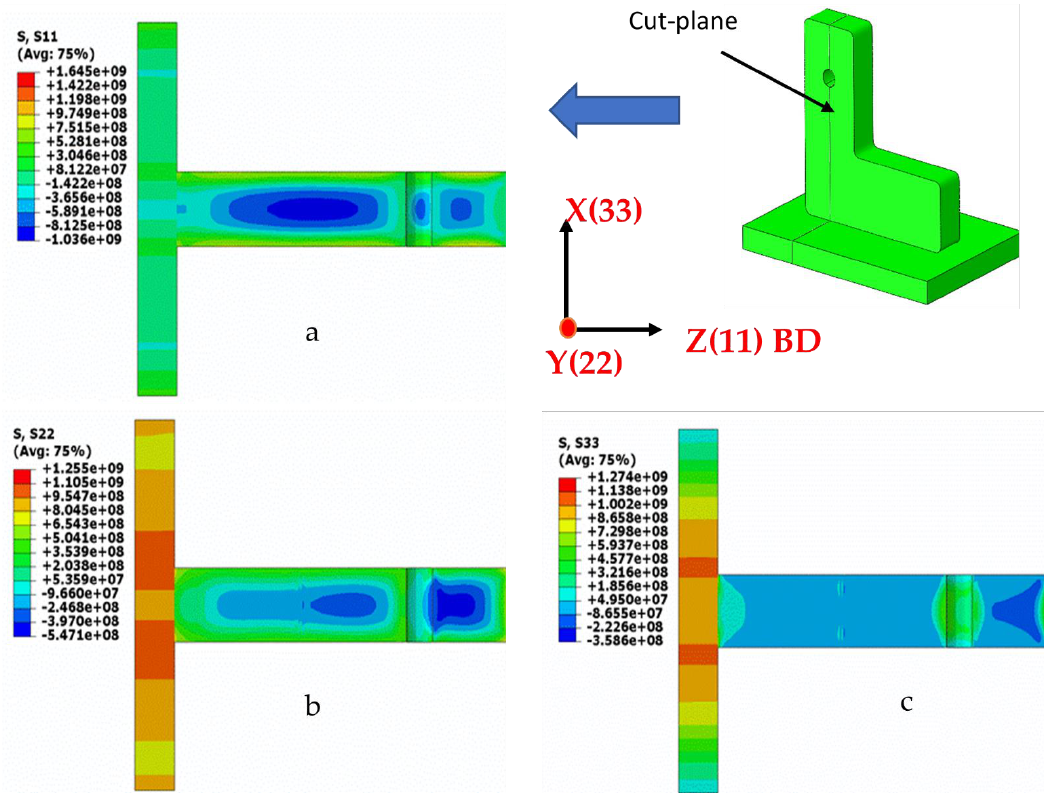
Figure 9. Cross-section view of the stress build up after the part is cooled to room temperature ( a ) stresses in Z-direction (building direction), ( b ) stresses in Y-direction, ( c ) stresses in X-direction. (Note: stresses are in Pa scale.).